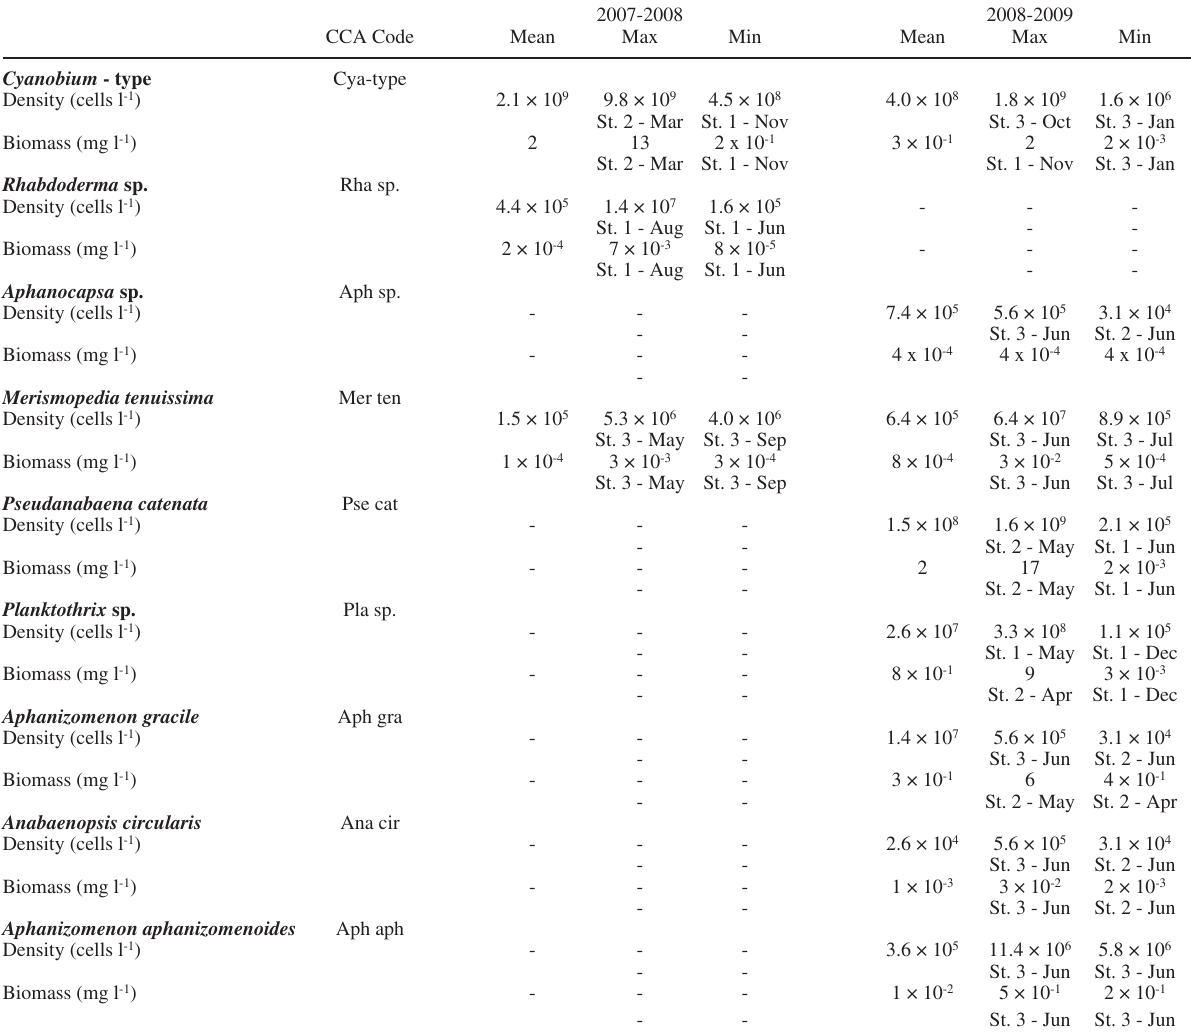
Table 1. – Mean, maximum, and minimum of density and biomass of the cyanobacteria observed in Cabras Lagoon during the two annual cycles of this